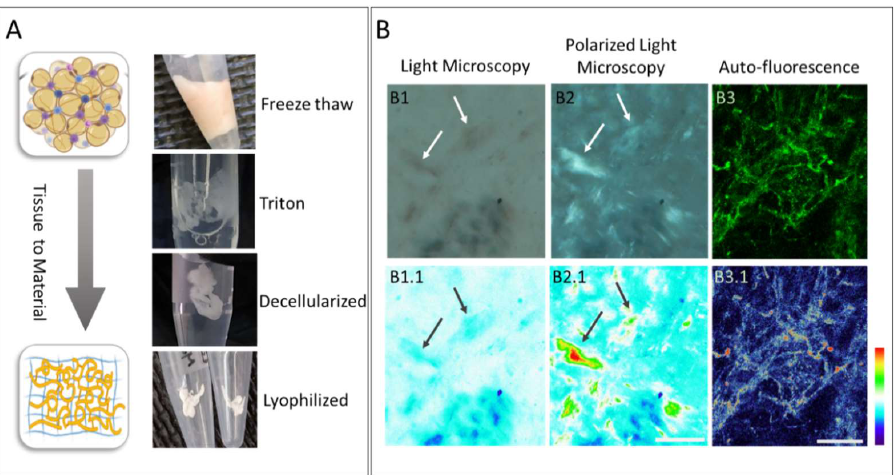
Figure 6. De-cellularization procedure from tissue to material and microscopy observation: ( A ) From top to bottom: WAT tissue in native state, triton treated loss in volume; tissue remaining ECM, lyophilized ECM ( B ). Microscopy images of unstained ECM (upper panel) and thermal illustration (lower panel) B1, ECM in white light, no clear areas of interest; B2, under light polarization microscope, clear areas of collagen due to birefringence properties B3, auto fluorescence of ECM accentuates fibrous structure. Color analysis Thermal depiction B1.1 clear areas shown, B2.1 areas of interest intensity comparable, B3.1 accentuates thicker areas, (B1–B2 scale bar = 100 µm, B3 scale bar = 20 µm).